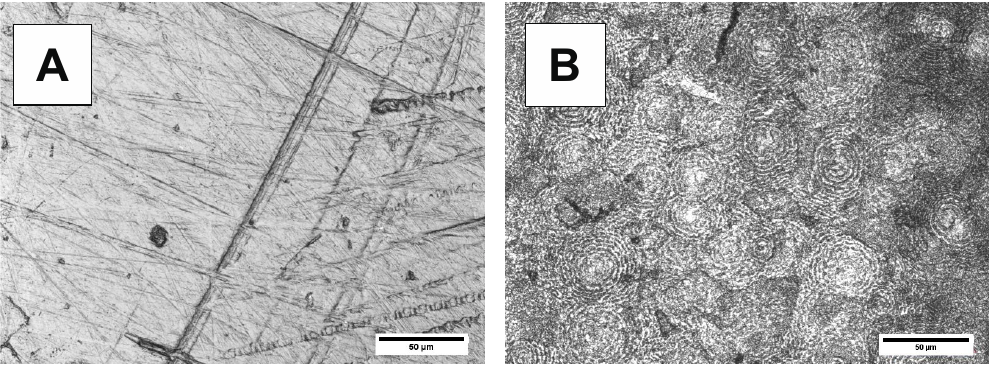
Figure 12. LSM micrographs of PBS-DLS 70:30 films ( A ) before and ( B ) after 24 days of degradation. Polymers 2018 , 10 , x FOR PEER REVIEW